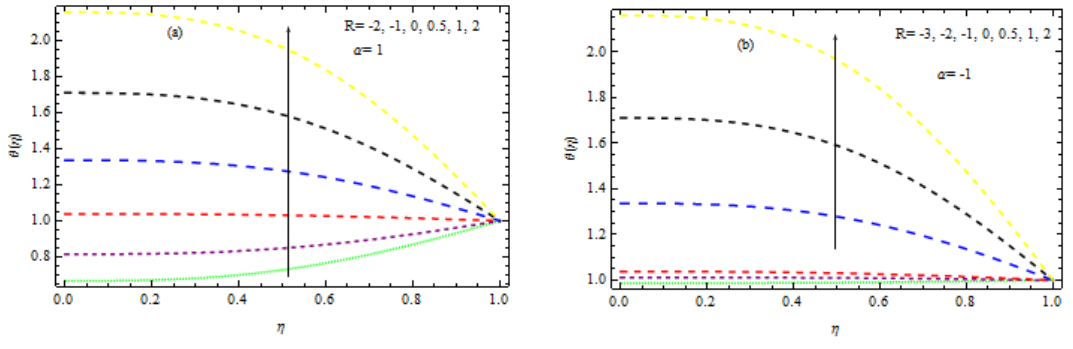
Figure 14. ( a , b ) Influence of R on temperature.